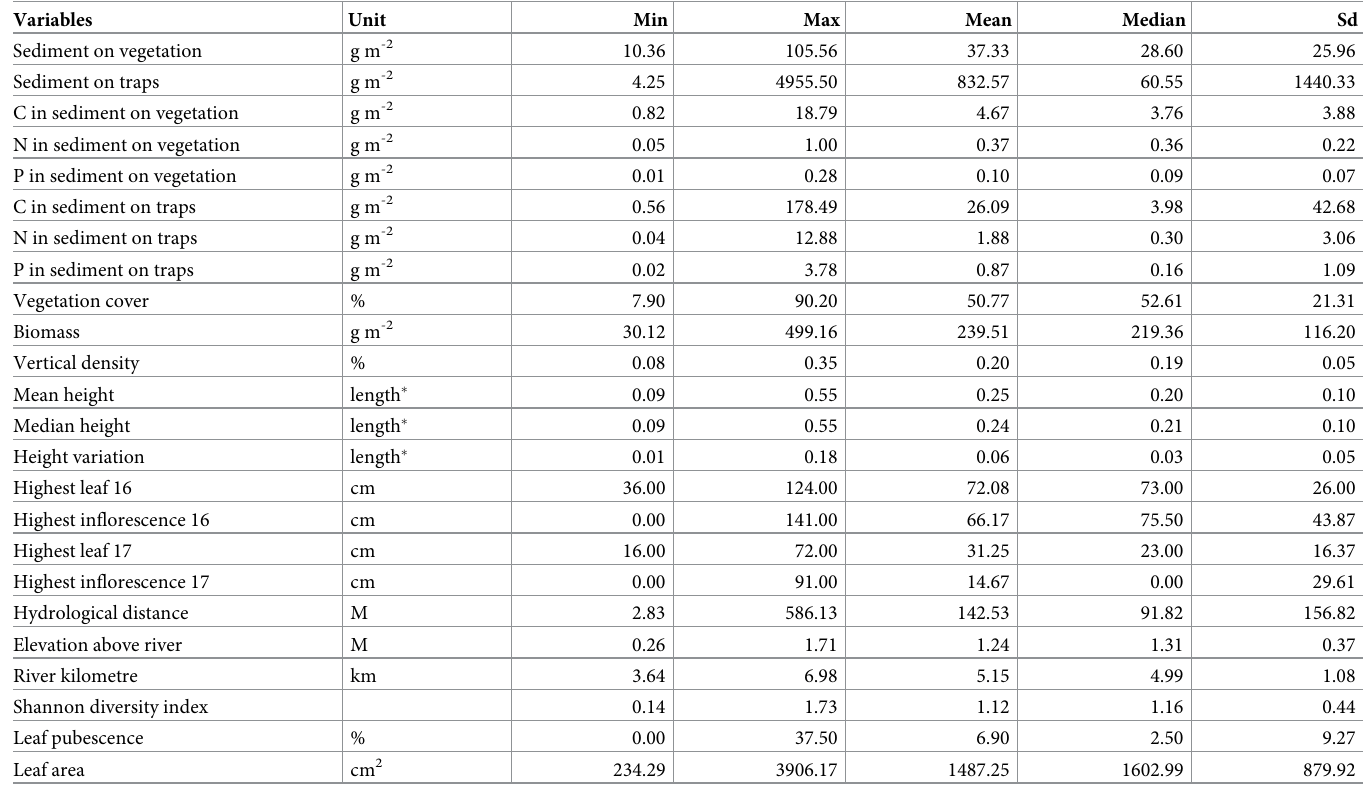
Table 2. Descriptive